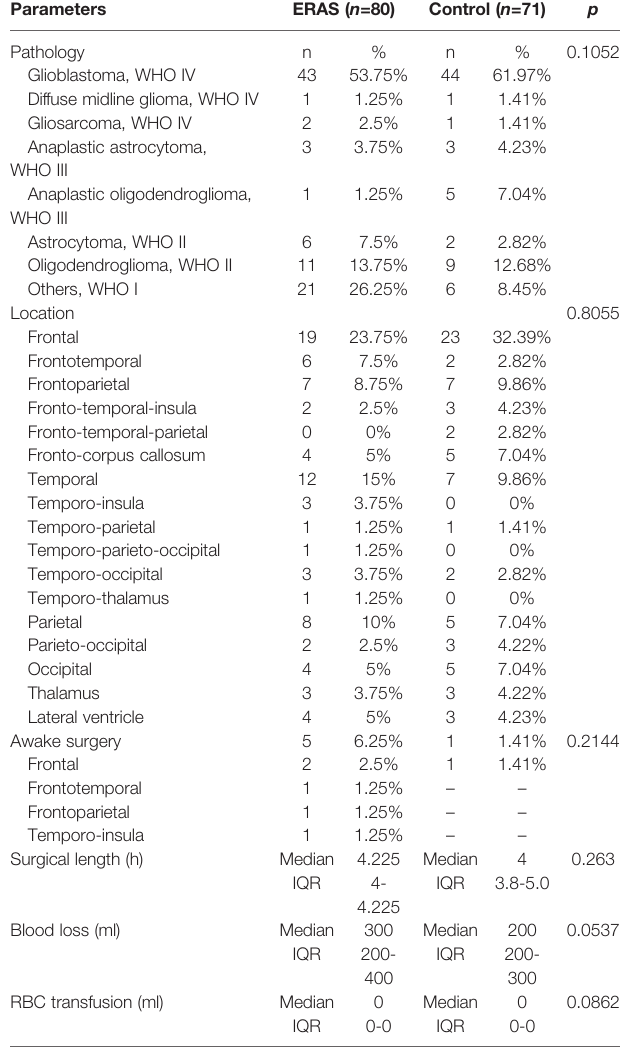
TABLE 2 | Summary of tumor and operation related